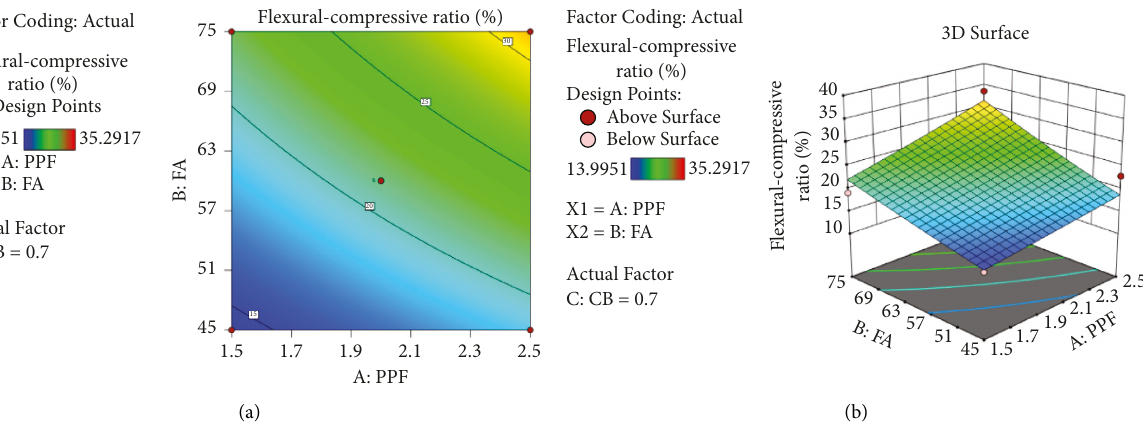
Figure 13: Contour plot of flexural-compressive ratio. (a) R3 and (b) 3D graph of R3.